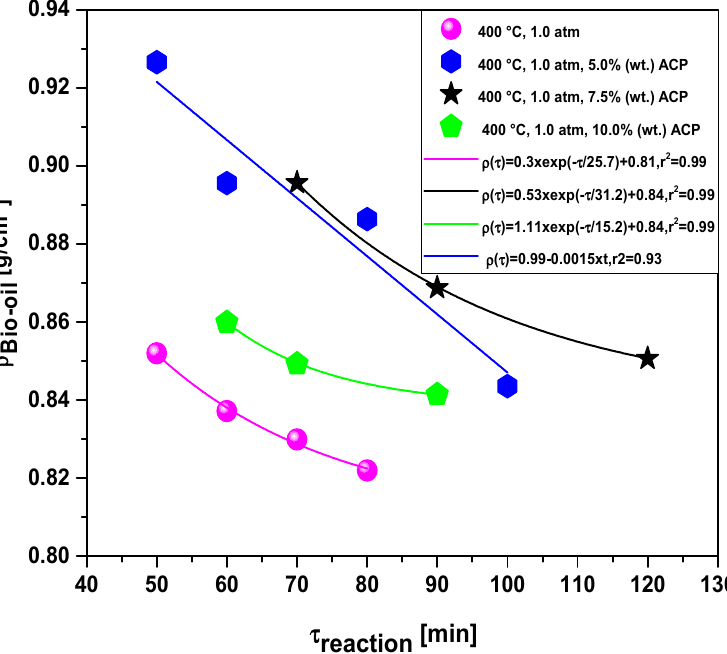
Figure 14. Effect of reaction time on the density of bio-oil by the upgrading of residual fat pyrolysis vapors at 400 ◦ C, 1.0 atmosphere, 0.0%, 5.0%, 7.5%, and 10.0% (wt.) activated carbon pellets impreg-nated with 10.0 M NaOH, using a catalyst fixed-bed reactor, in a semi-pilot scale two-stage reactor of 2.0